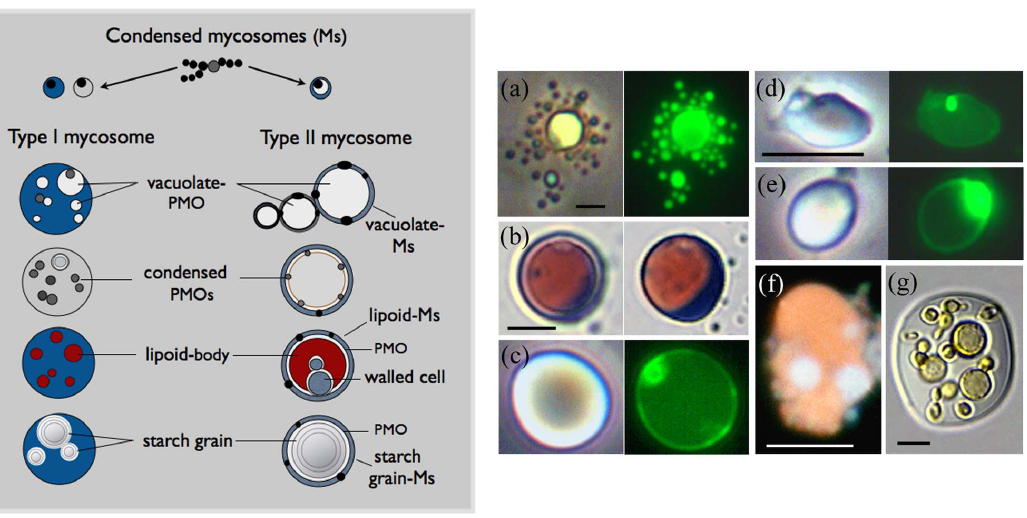
Figure 4. Overview of mycosome structure: light microscopy. Left cartoon: Condensed-Ms develop as spheroid or filamentous protoplasts that express one or more vacuole-like PMOs. Type I Ms develop as acytoplasmic (grey) or cytoplasmic (blue) protoplasts that express multiple PMOs. Type II Ms express a single PMO, bounded by a narrow budding protoplast. The PMO may appear vacuolate, or contain a lipoid compartment, a starch grain, or a walled parent-type cell. Right: Examples of Type II lipoid-Ms. (a) A lipoid-Ms cultured from Cuscuta subinclusa (yellow- pigmented) shows prolific budding (phase contrast and SYTO 9 fluorescence). (b) A Rhodotorula Type II Ms at two focal planes (AB/SIV stain). The red lipoid-body (left) is expressed within the non-staining vacuole-like PMO; condensed-Ms (right) are released from the crescent-shaped protoplast. (c–e) Viewed with phase contrast, refractive lipoid bodies (left) are bounded by a SYTO-9 staining envelope (right) that contains a fluorescing body. (c and e) Saccharomyces . (d) Aureobasidium. (f) An orange autofluorescing (chlorophyll-containing) lipid body from a Psilotum chloroplast contains two prominent DAPI-stained Ms (see also [22]; Fig. 3a–c). (g) Budding yeast-like forms within the lipoid-body of a large Filobasidium Type II Ms (MR stain). Bars =5.0 m m. Use bar d for c and